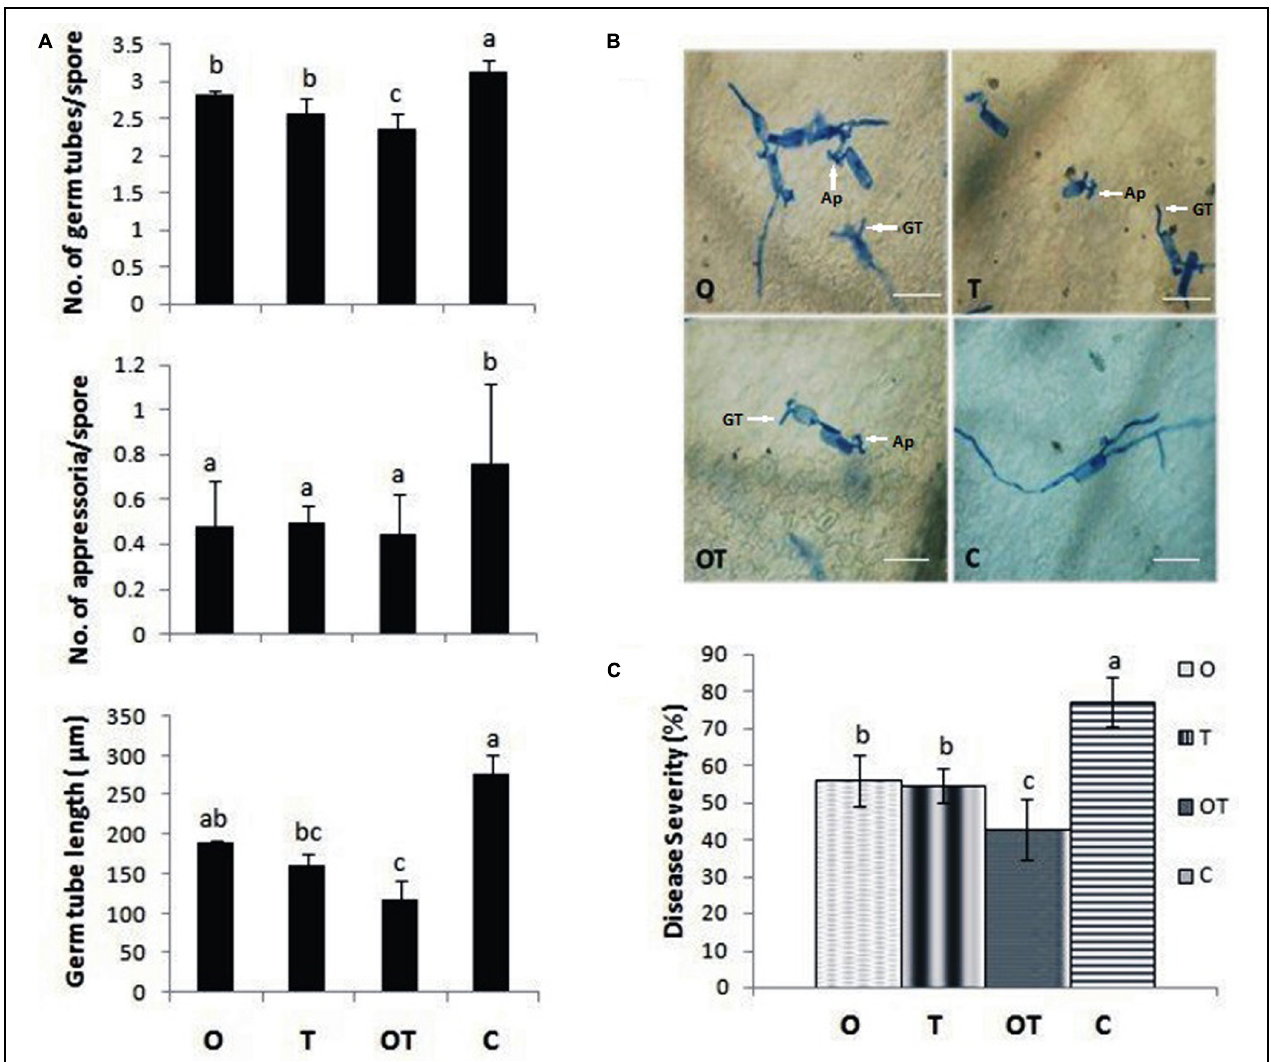
FIGURE 7 | Erysiphe pisi conidia growth and disease development on pea leaves. (A) Inhibition of spore germination in terms of number of germ tubes/spore, number of appressoria/spore and longest germ tube length on plant leaves raised from different treatments: O- P. fluorescens OKC, T - T. asperellum T42, OT- combination of OKC and T42, C- Control after 24 h of E. pisi challenge. (B) Confirmation of (A) on plant leaves by histochemical staining in same treatments. GT represents germ tube and Ap represents appressorium. (C) Disease severity of E. pisi on pea plants 2 weeks after inoculation. Error bars represent SD from means of three measurements. Different superscript letters indicate data significantly different from the other treatments ( P ≤ 0.05; Duncan’s multiple range test). The bars are equivalent to 100 μ m.